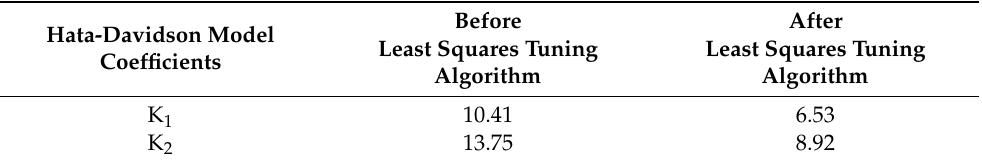
Figure 8. GUI of link budget plots of modified Hata-Davidson empirical model at 15 m altitude. Table 3. Two Hata-Davidson model coefficients.